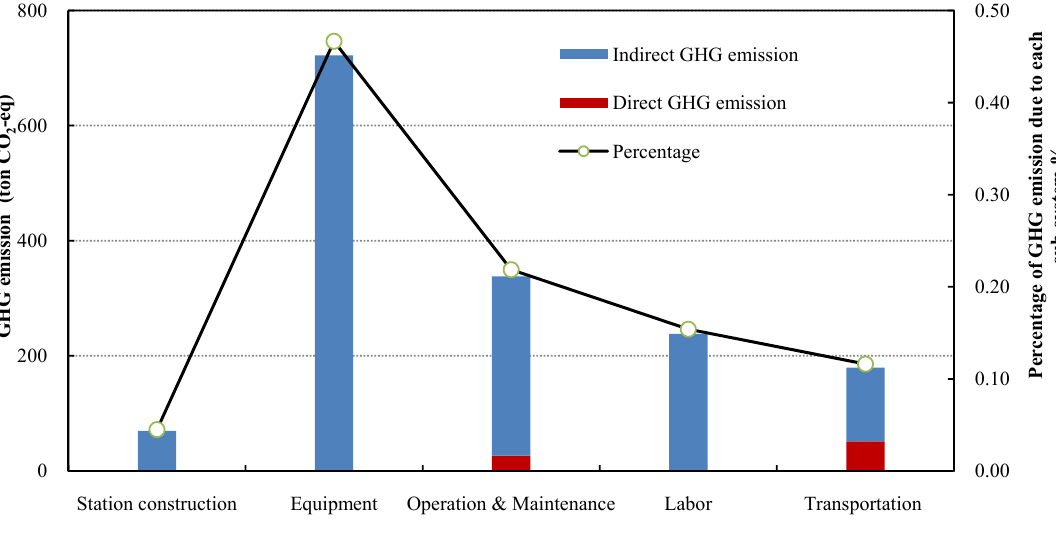
Figure 4. GHG emissions associated with each sub-system in the life cycle of a village-level biomass gasification